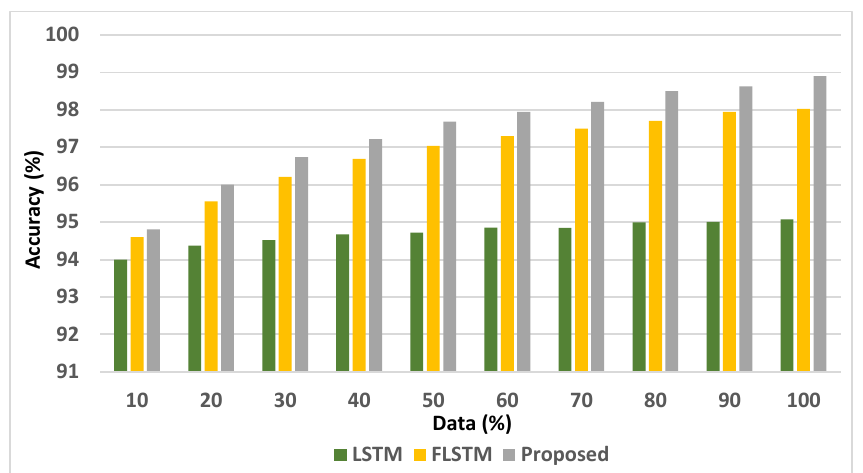
Figure 5. Accuracy analysis.